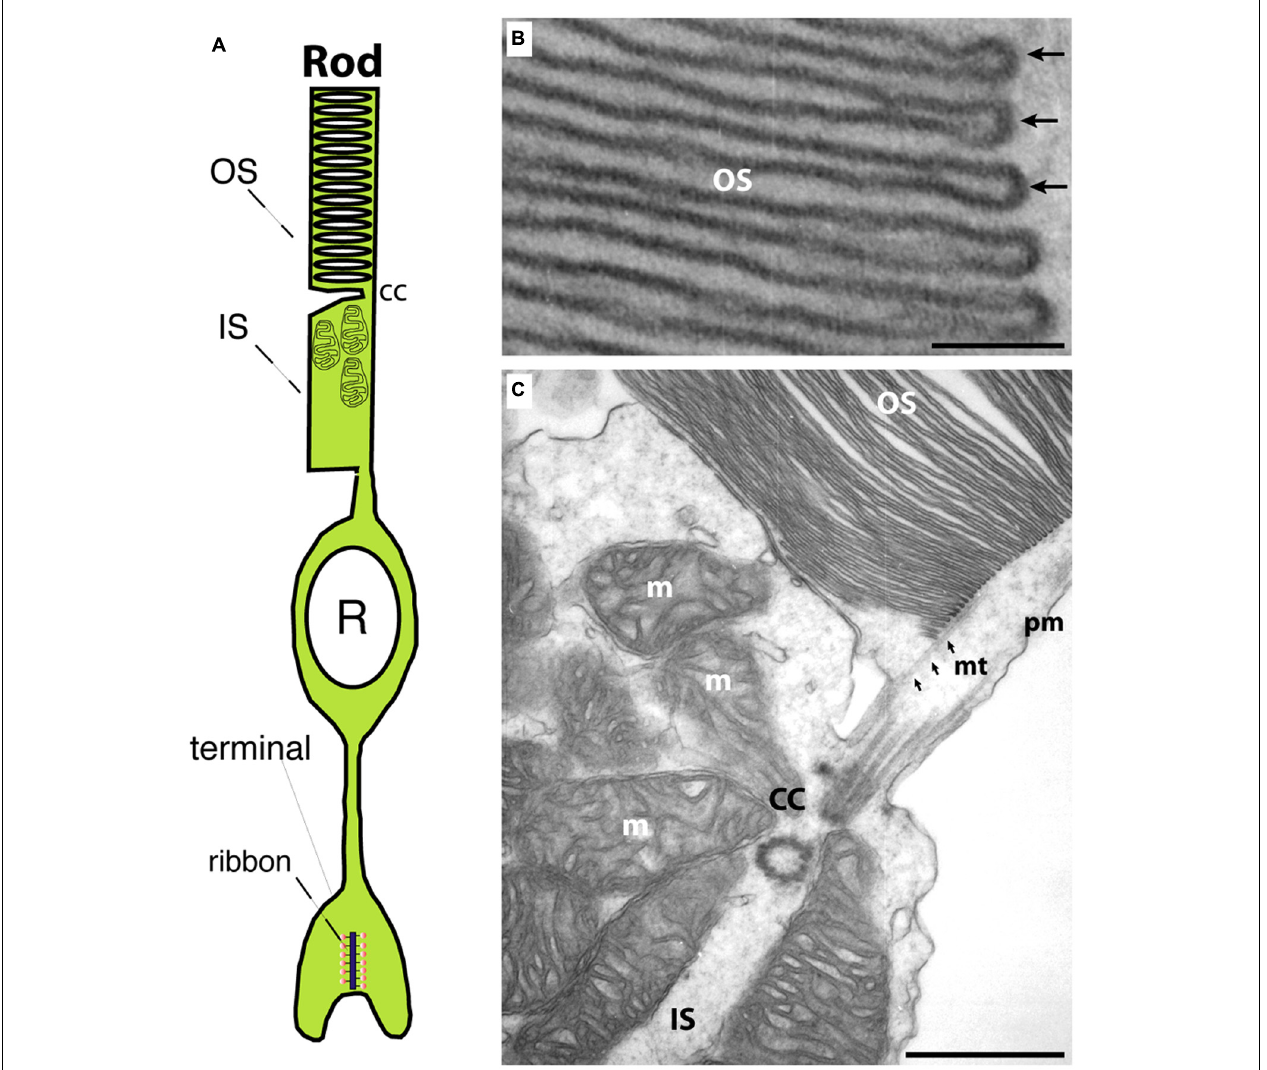
FIGURE 1 | (A) Photoreceptors show a bipolar morphology. A distal process forms the outer segment (OS) and the inner segment (IS). The OS is the place where phototransduction takes place. The IS represents the metabolic center of the photoreceptor. An inner, vitread process ends in the presynaptic terminal that contains a synaptic ribbon at the active zone. (B) Transmission electron micrograph of an outer segment (OS). Densely packed arrays of membrane disks can be observed. The arrows in (B) point to individual disks. In the OS, phototransduction